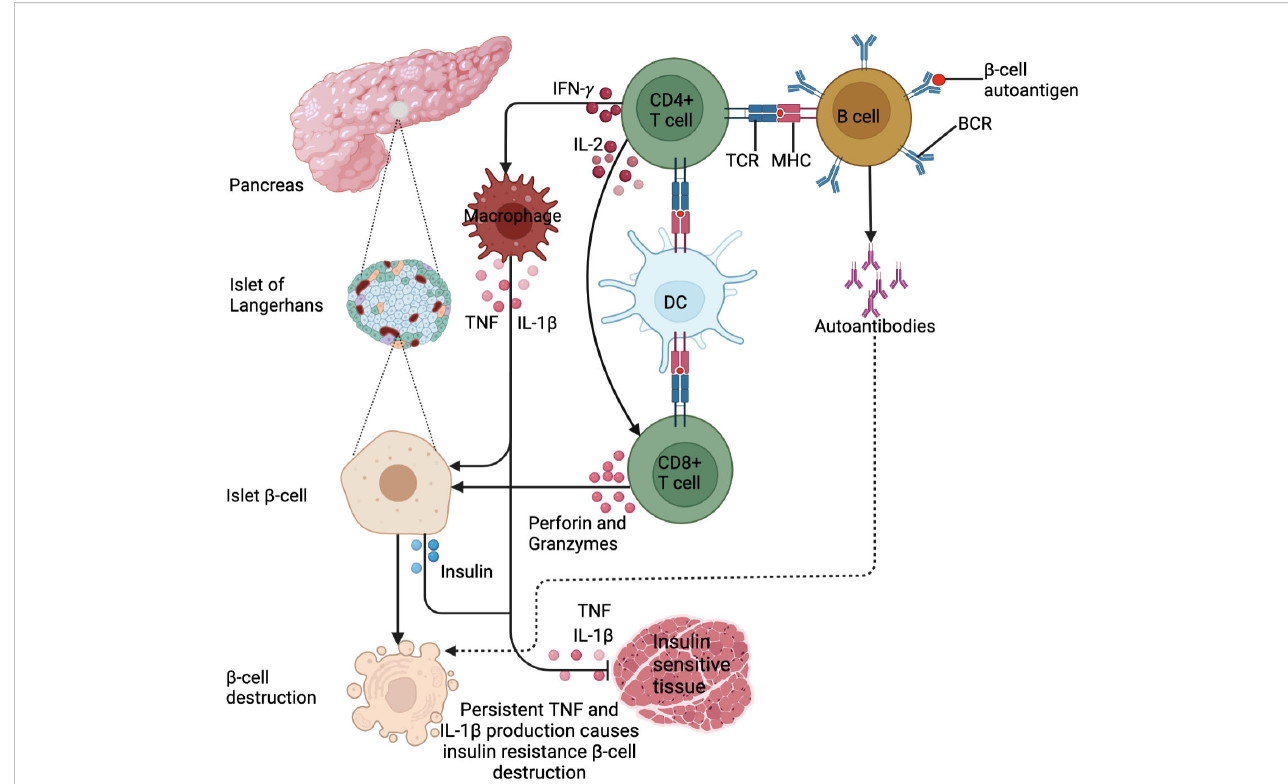
FIGURE 1 DM pathogenesis. DM is an immune-modulated disease. For T1DM, antigen presentation by B cells and DCs drives the activation of b − cell-speci fi c T cells. In addition, the exposure of B cells to b − cell autoantigens leads to the production of islet b − cell targeting autoantibodies. These lead to b − cell destruction. For T2DM, IFN- g production by activated CD4 + T cells activates macrophages to produce IL-1 b and TNF. This low chronic-grade in fl ammation causes insulin resistance or inhibits insulin uptake in tissues. In addition, the cytokines cause insulin secretion by b -islet cells to compensate for reduced insulin sensitivity. These stimulate the Islet b cells to produce insulin. Persistent IL-1 b and TNF production triggers b -cell islet